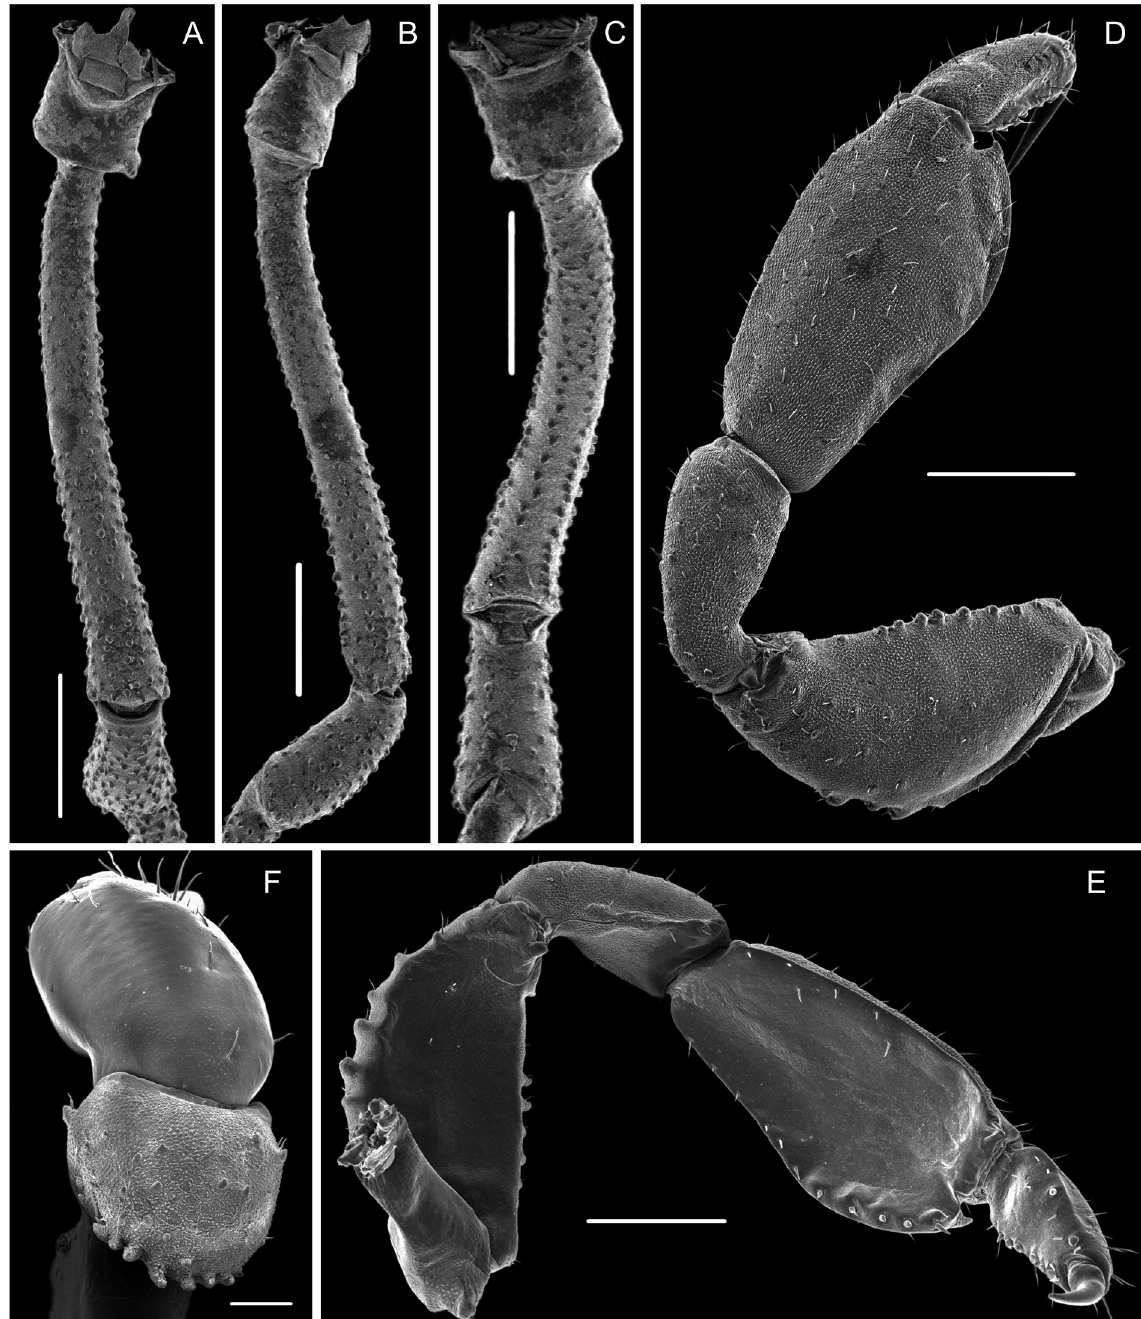
Fig. 25. Eulibitia pollux sp. nov., ♂ (ICN-AO 422). A . Trochanter, femur and patella of leg IV, dorsal view. B . Same, prolateral view. C . Same, ventral view. D . Left pedipalpus, ectal view. E . Same, mesal view. F . Left chelicera, dorsal view. Scale bars: A–C = 1 mm; D–E = 500 µm; F = 200